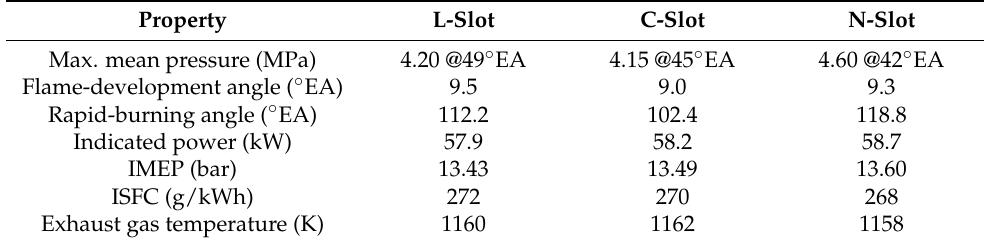
Table 3. Simulation results for different slot positions in Wankel engine with two L-plugs.